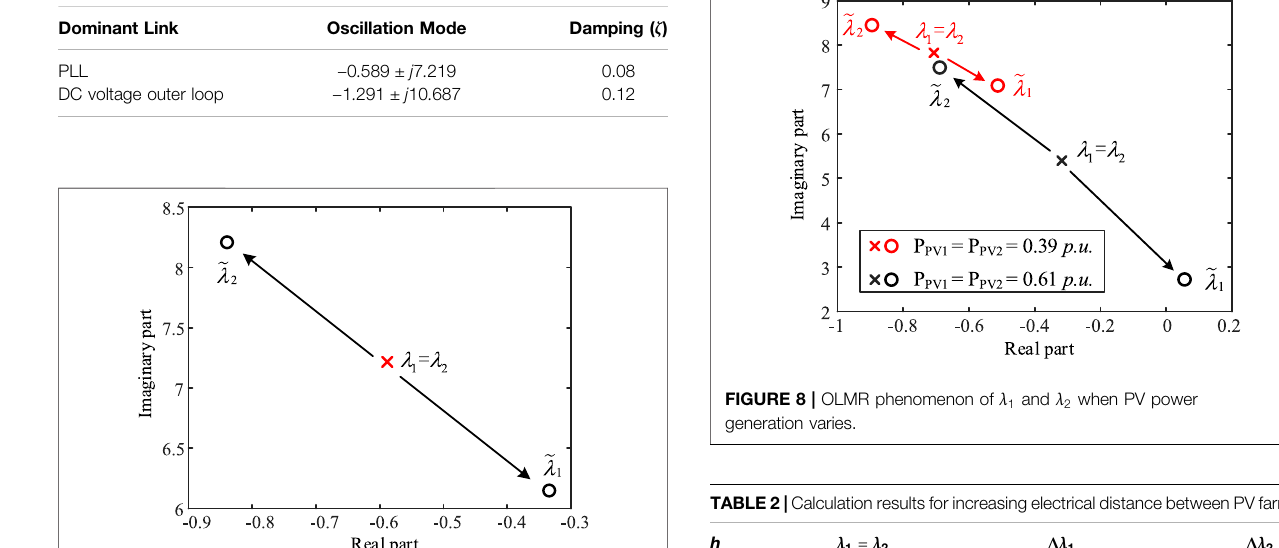
TABLE 1 | Open-loop oscillation modes of the PV farm.